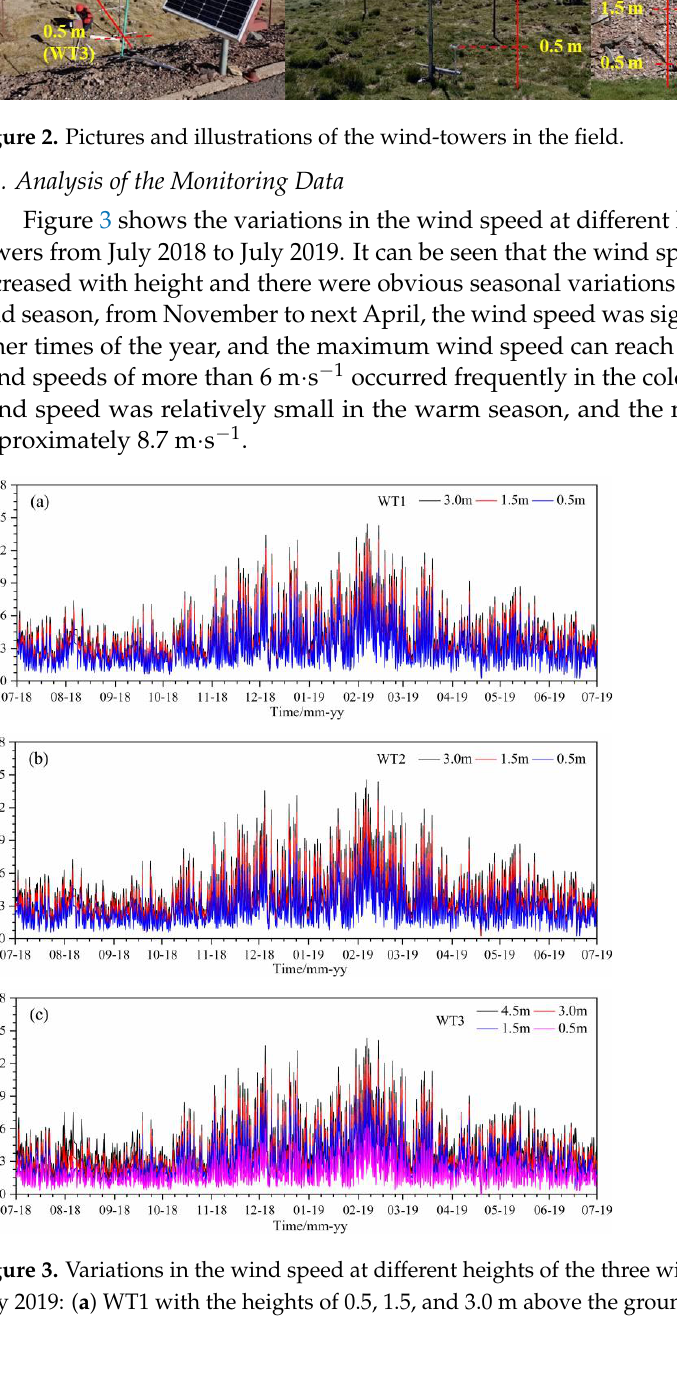
Figure 4. Mean annual wind speed at different heights of the three wind-towers.